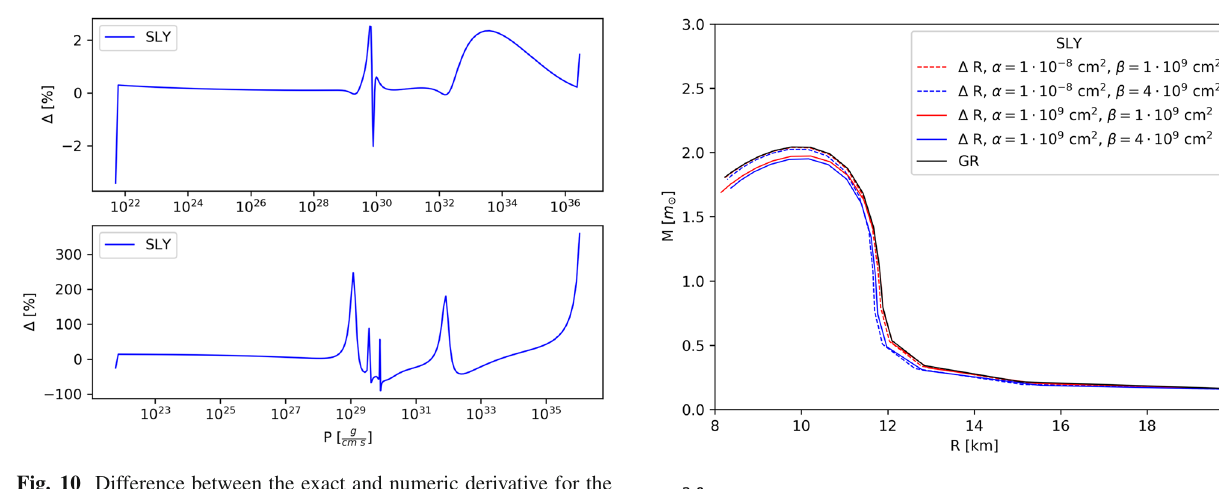
Fig. 10 Difference between the exact and numeric derivative for the first (upper panel) and second derivative (lower panel) of the EoS